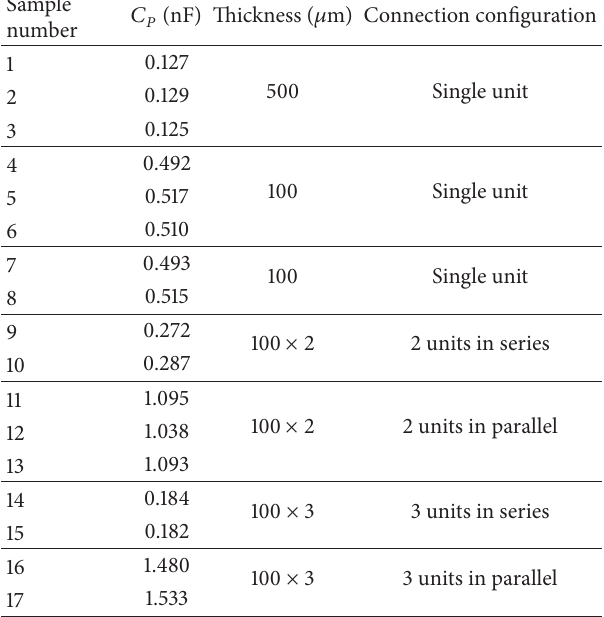
Figure 12: The experimental and simulated data of 𝑈 𝐿 after the PVDF samples 7 ∼ 17 had been operated by the applied force (50 + 30 sin 4𝜋𝑡)𝑁 for 1min. Table 2: PVDF samples for verifying the models.